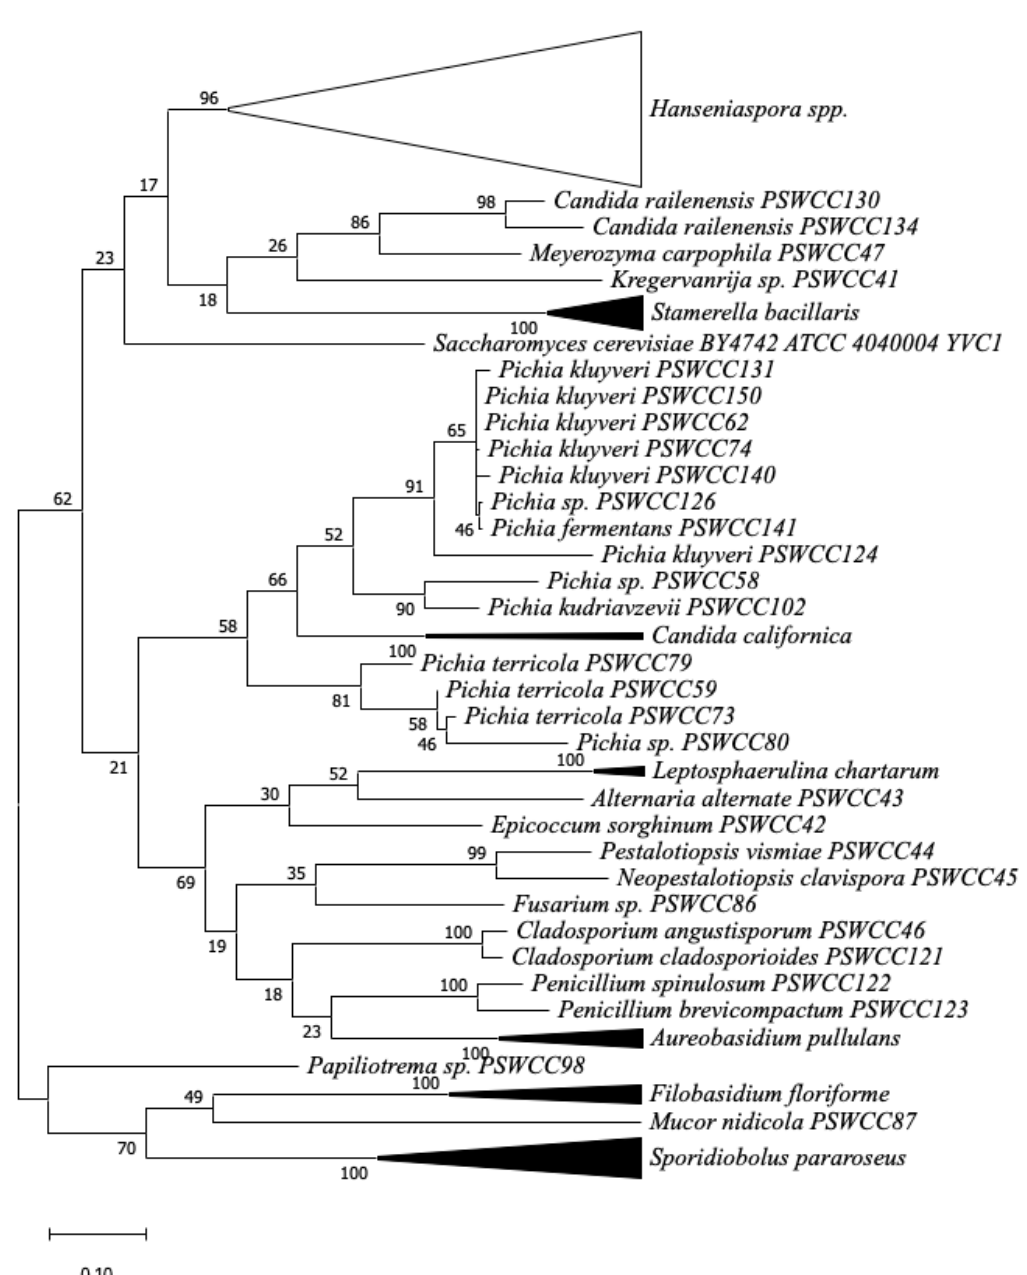
Figure 1. Phylogenetic diversity of fungal strains associated with Chambourcin hybrid grape must during spontaneous fermentation based on ribosomal internal transcribed spacer (ITS) regions and 5.8S rRNA gene sequences. Branches corresponding to partitions reproduced from less than 50% bootstrap replicates were collapsed. The percentage of replicate trees in which the associated taxa clustered together in the bootstrap test are shown next to the branches. Hanseniaspora clade was suppressed into a black empty triangle including all Hanseniaspora species clustered with 96% bootstrap support. Subtrees including same species supported by 100% bootstrap value were suppressed and represented as solid black triangles, including Starmerella bacillaris , Candida californica , Leptosphaerulina chartarum , Aureobasidium pullulans , Filobasidium floriforme , and Sporidiobolus pararoseus strains.